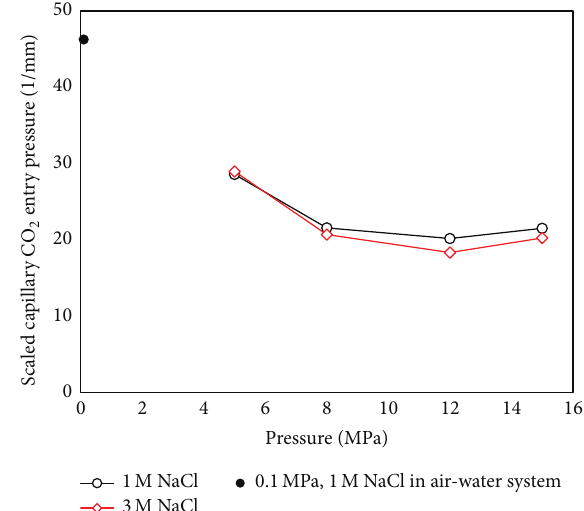
Figure 8: Scaled capillary CO 2 entry pressure with increased pressure using 1M and 3 M